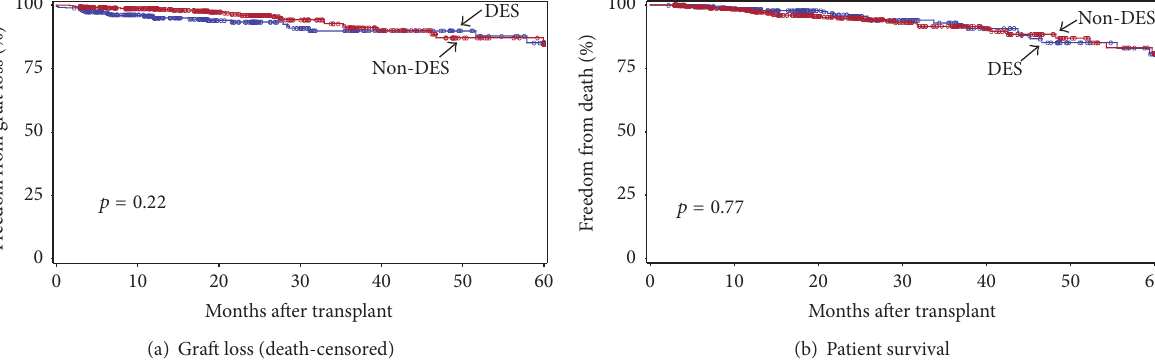
associated complications including PTLD, BKAN, and PML in HS kidney transplant patients under antiviral surveillance with antiviral prophylaxis for 6 months after transplant and close monitoring viral infection by PCR for early detection and early